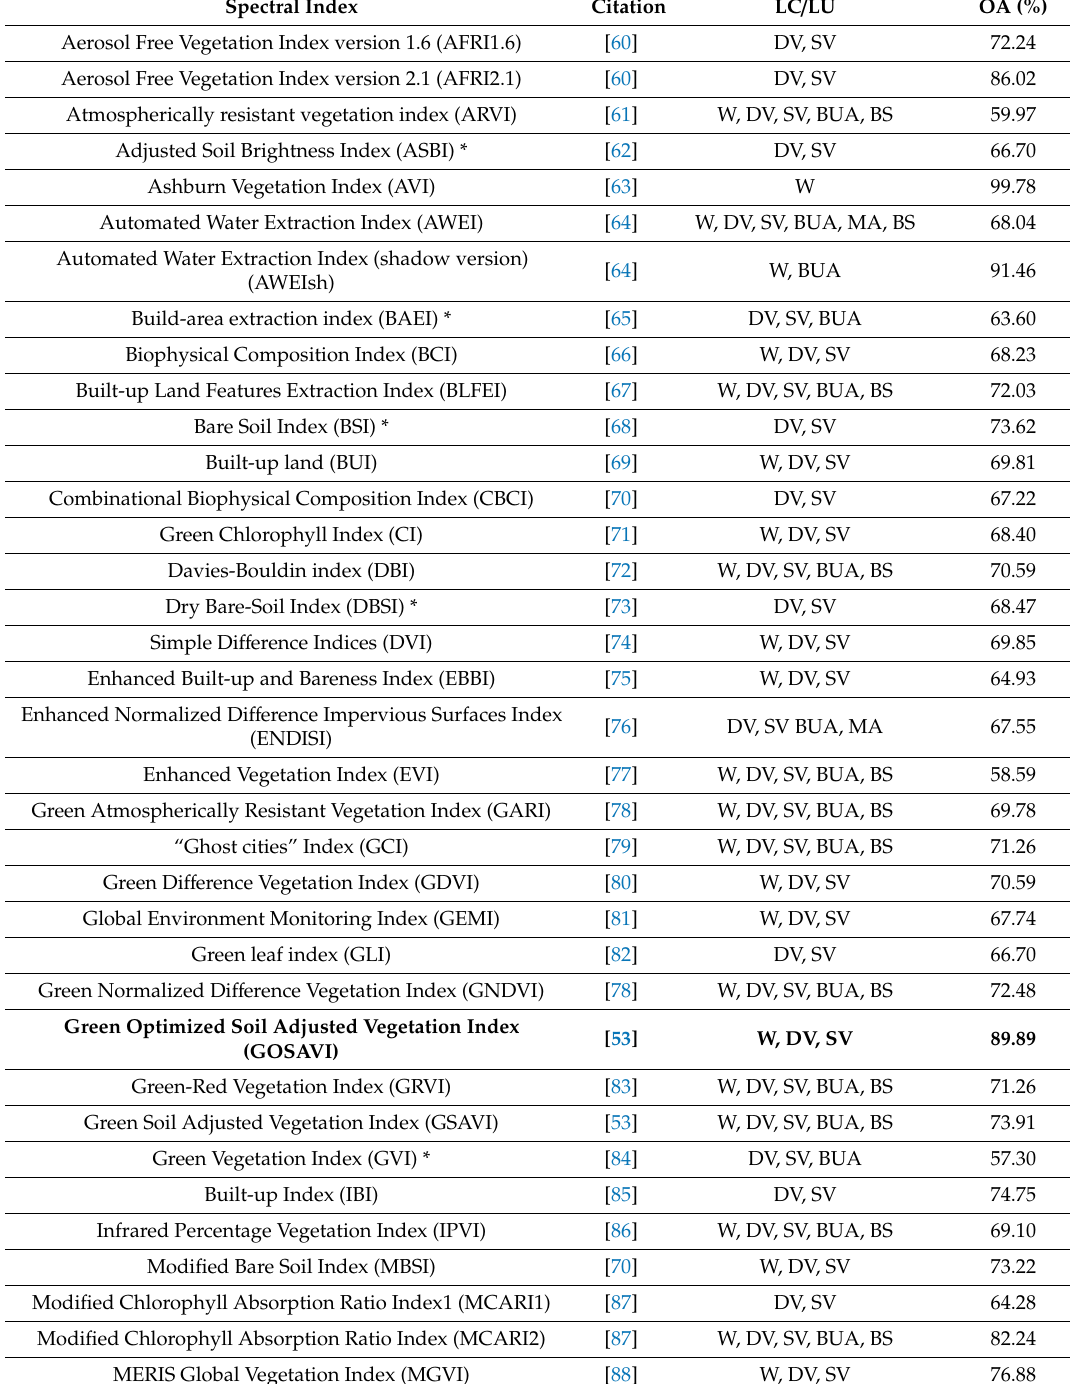
Table 1. Main commonly used classification indices listed in alphabetical order. Indices in bold show the best performance. LC / LU column describes the land cover / land use classes detected from each index. OA column reports the best overall accuracy of each index. LC / LU, land cover / land use; OA: overall accuracy; W, water; DV, dense vegetation; SV, sparse vegetation; MA, mining areas; BS, bare soil; BUA: built-up area; *, water mask is required; -:, no classes were detected. Spectral Index Citation LC / LU Aerosol Free Vegetation Index version 1.6